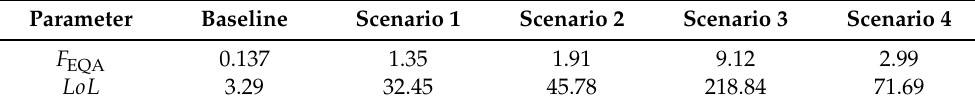
Figure 3. Transformer life indices without EV and with EV charging, ( a ) hottest-spot temperature, θ H ; ( b ) accelerated aging factor, F AA . Table 1. Transformer’s F EQA and LoL without EV and with EV